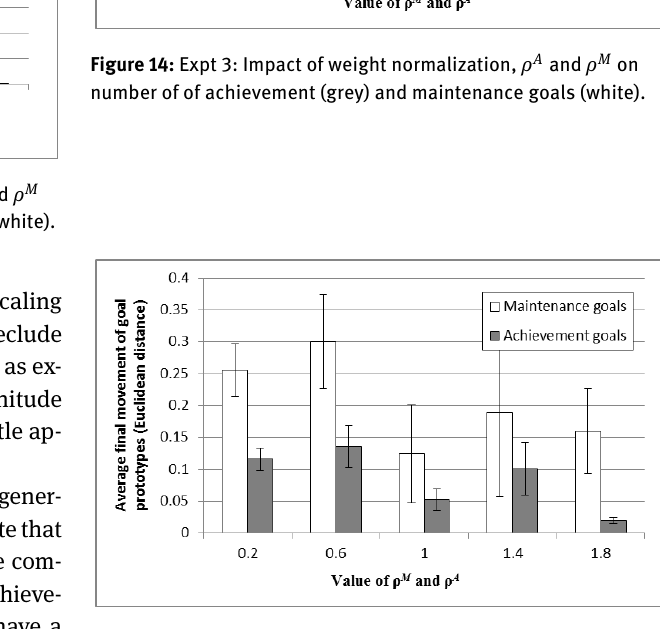
Figure 15: Expt 3: Impact of weight normalization and ρ M and ρ A on convergence of cluster prototypes in the first run of experiment